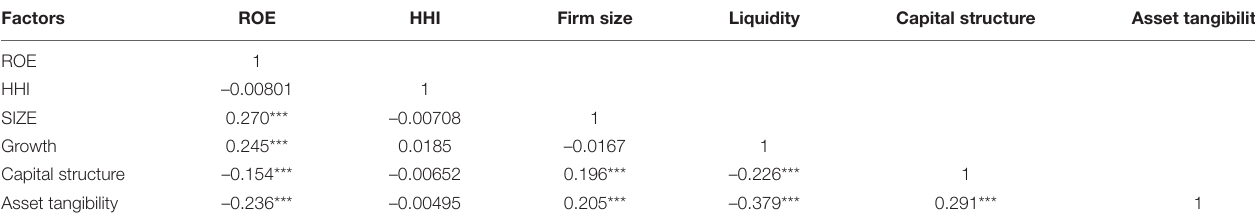
TABLE 2 | Correlation matrix of the study